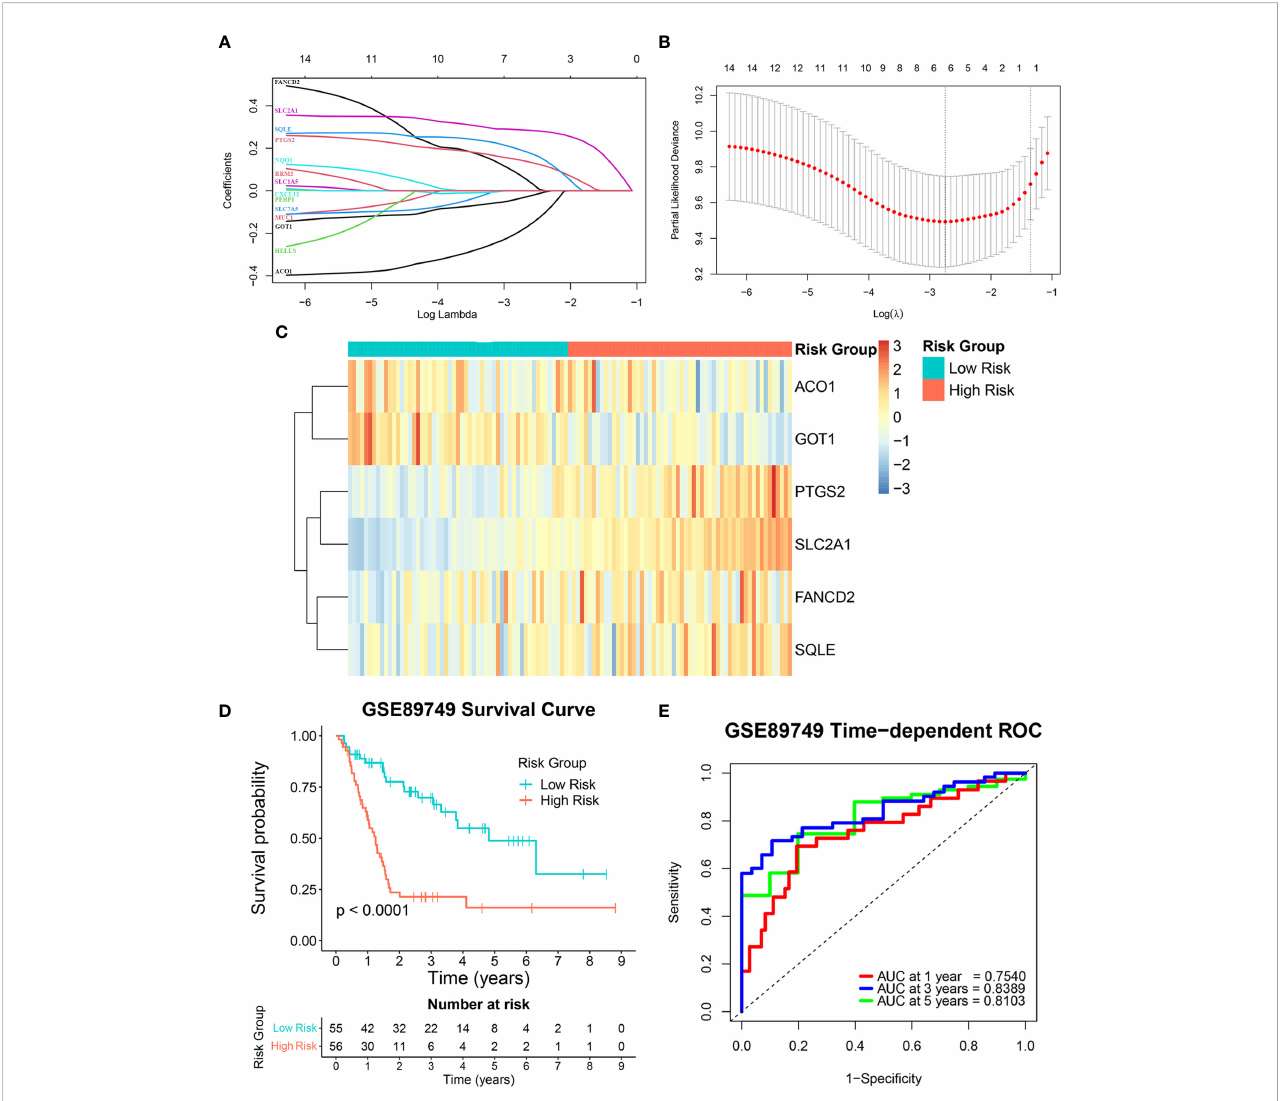
FIGURE 3 Construction of the ferroptosis-related gene (FRG) signature in a training cohort. (A, B) A least absolute shrinkage and selection operator (LASSO) Cox regression analysis of the candidate genes. (C) A heatmap showing the expression levels and distribution of the six-FRG signature. (D) A Kaplan-Meier curve showing the overall survival of CCA patients. (E) Area under the curve (AUC) of time-dependent receiver operating characteristic (ROC) curves showing the six-FRG signature ’ s predictive ef fi cacy for survival time in CCA